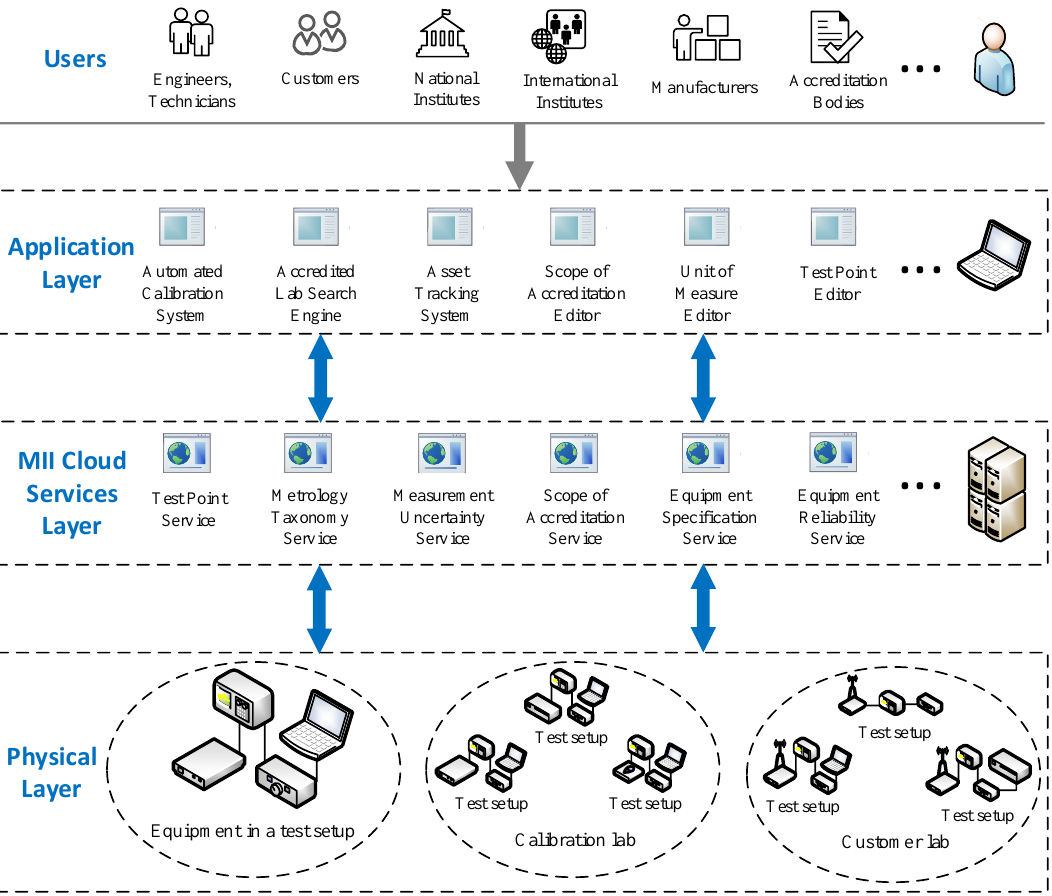
Figure 3. The IoMT architecture